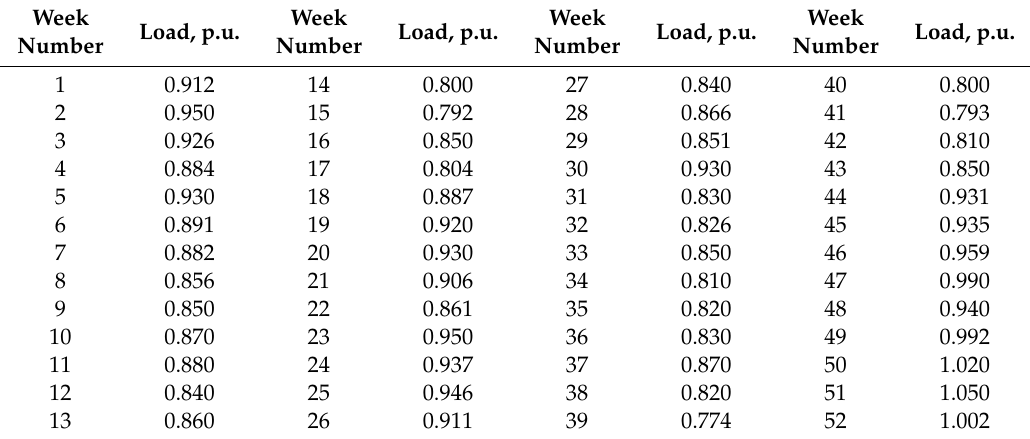
Table 4. The weekly maximum loads for the year under